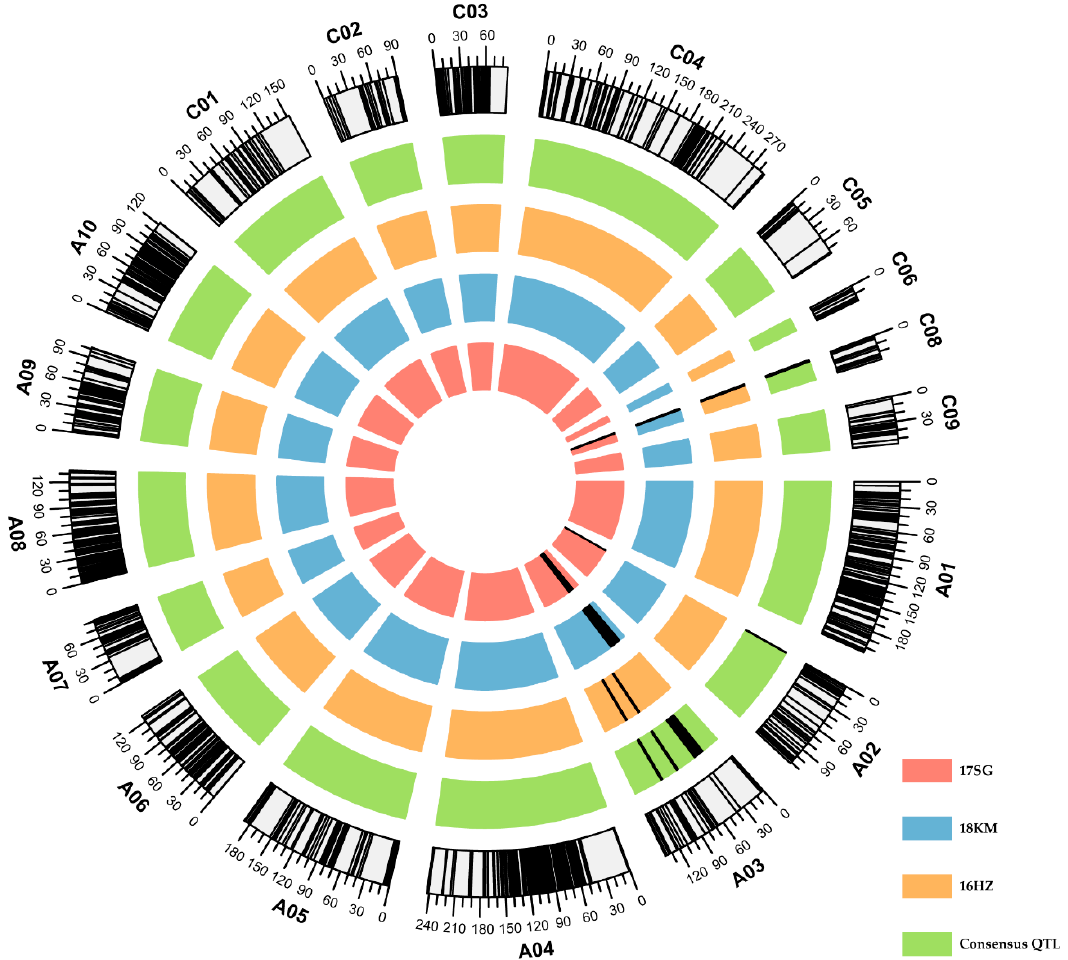
Figure 2. Distribution of markers and position of flowering-time quantitative trait loci (QTL) on linkage groups. Black bars in outermost circle of each block represent marker distribution on linkage groups, numbers outside each block represent linkage group genetic distances (cM). Letters plus numbers indicate linkage group number. Black bars on four circles from the inside to the outside represent QTLs identified in three environments (17 SG, 18 KM, and 16 HZ) and the consensus QTLs obtained from QTL meta-analysis. Black bar range represents QTL confidence intervals.